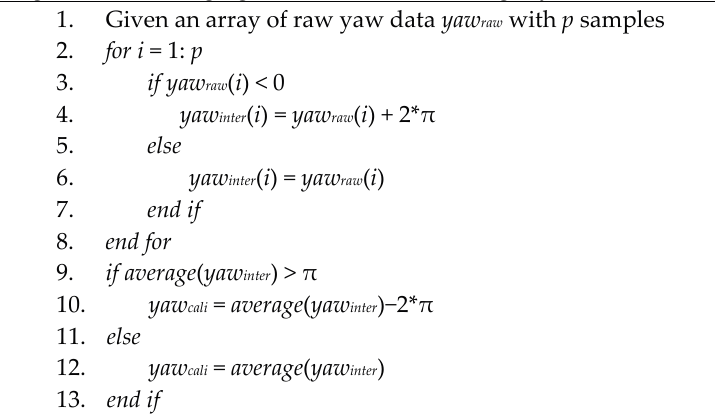
Algorithm 1 Averaging Yaw Data in 180 o